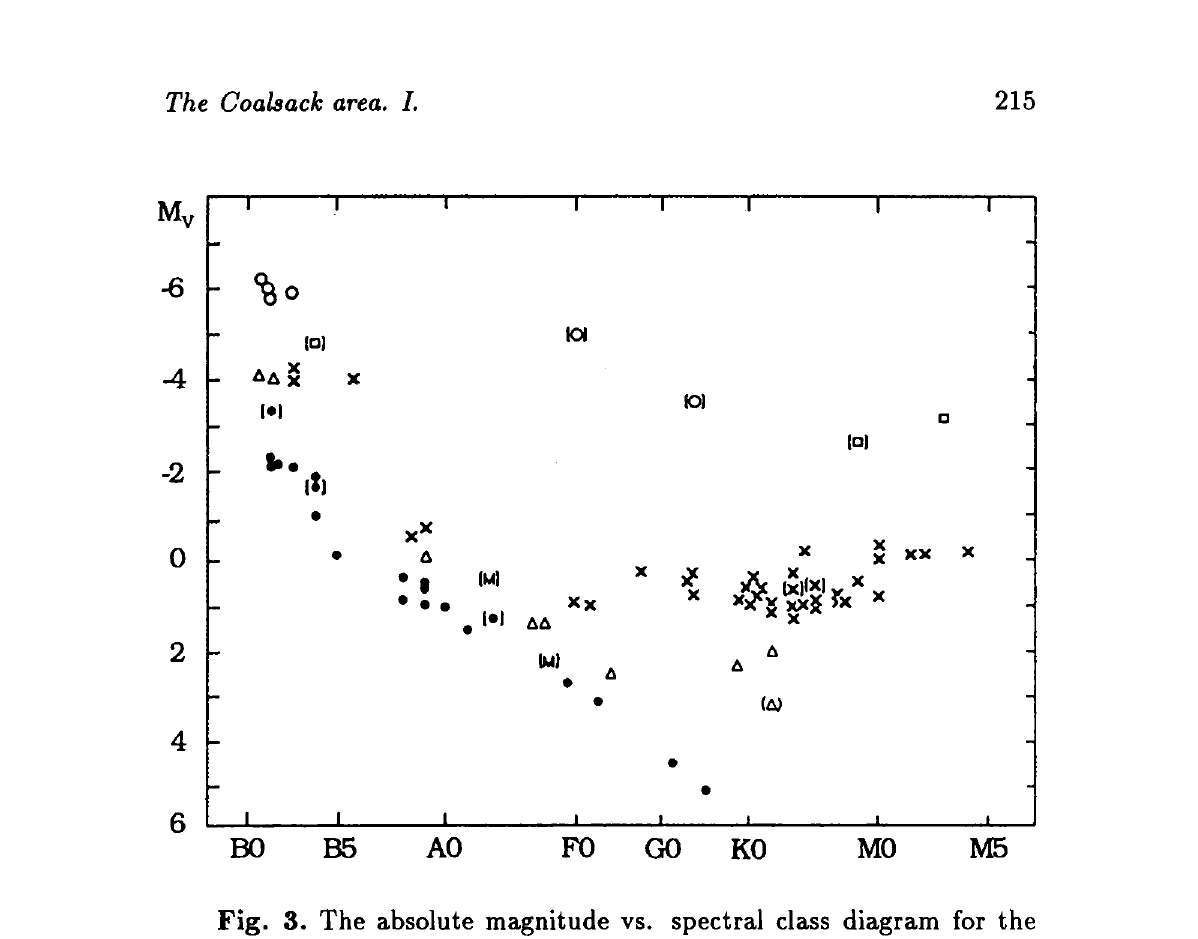
Fig. 3. The absolute magnitude vs. spectral class diagram for the stars investigated. Dots indicate luminosity V stars, triangles indicate luminosity IV, crosses luminosity III, squares luminosity II and circles luminosity I stars. Two suspected metallic-line stars are shown. Symbols shown in brackets indicate stars classified with lower